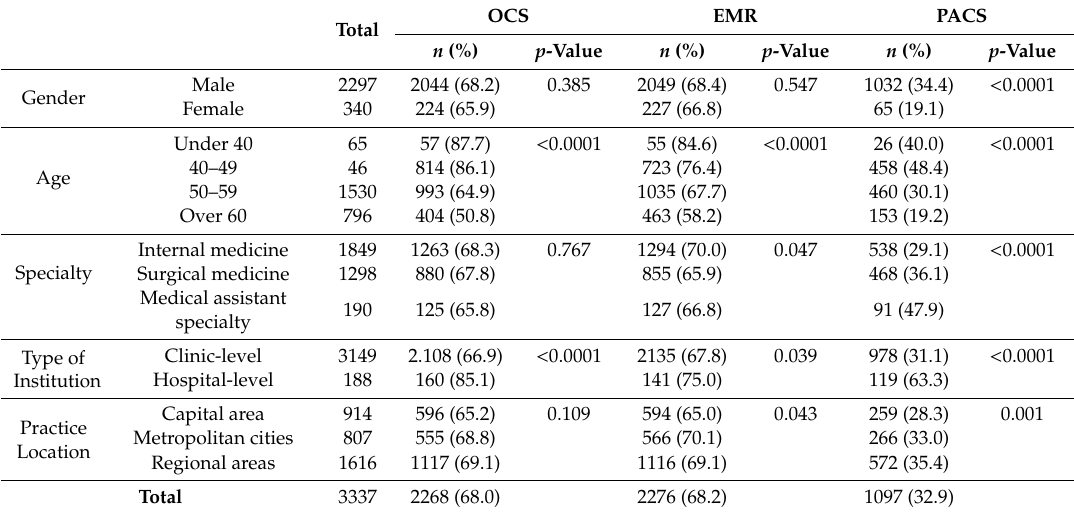
Table 2. Current status of health information system (HIS) adoption among self-employed physicians.